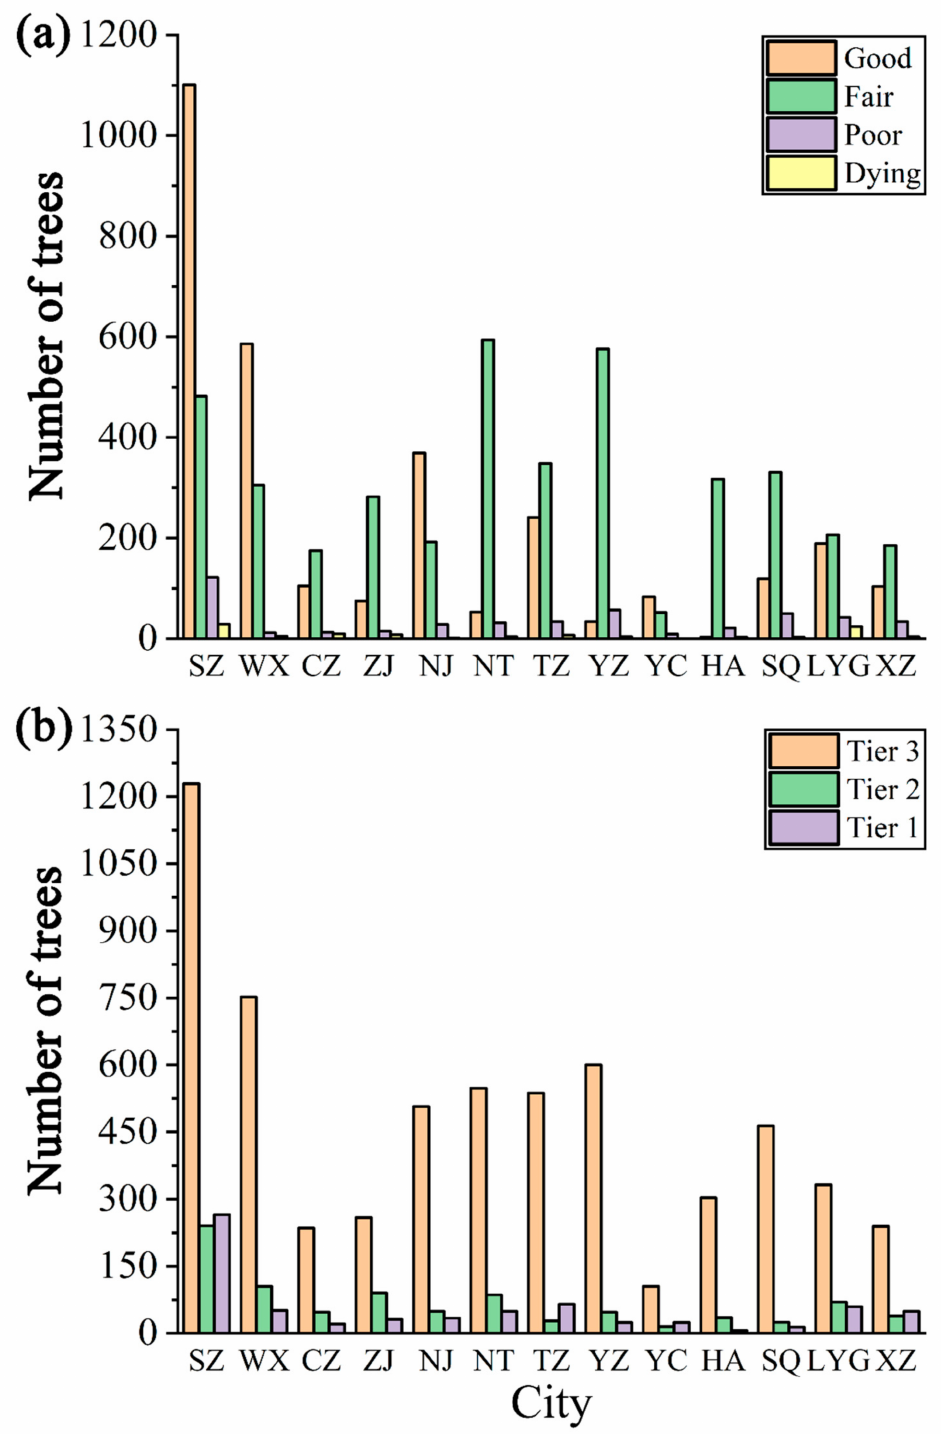
Figure 5. Heritage trees’ abundance by growth status ( a ) and tree age ( b ) in 13 cities of Jiangsu Province, eastern China. Refer to Table 1 for the meaning of the abbreviated